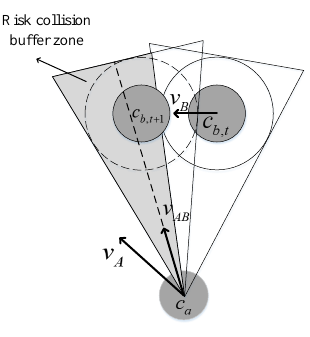
Figure 4. Speed barrier